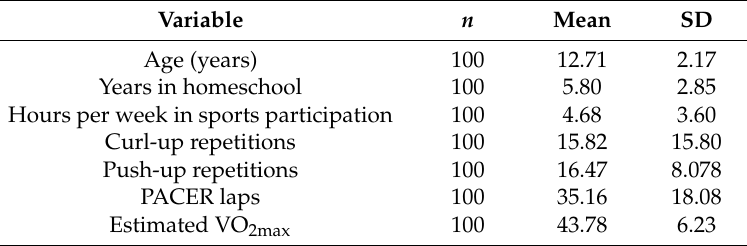
Table 2. Descriptive characteristics for physiological